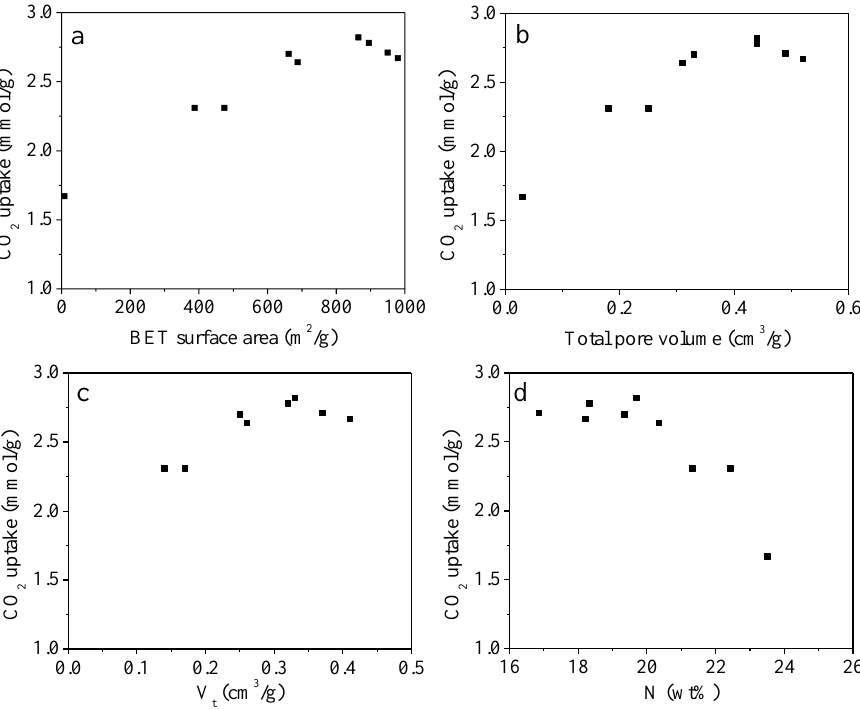
Figure 6. Plot of each porous properties characteristics ( a ) S BET , ( b ) V 0 , ( c ) V t and ( d ) nitrogen content versus CO 2 uptake at 25 ◦ C and 1 bar.